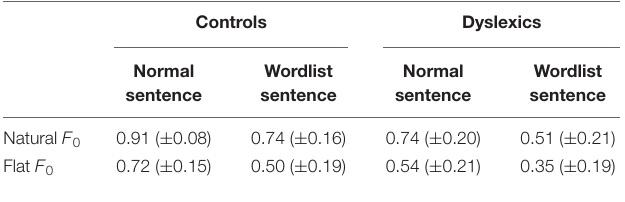
TABLE 2 | Mean accuracy ( ± SD) of each condition for the two groups. Controls Dyslexics